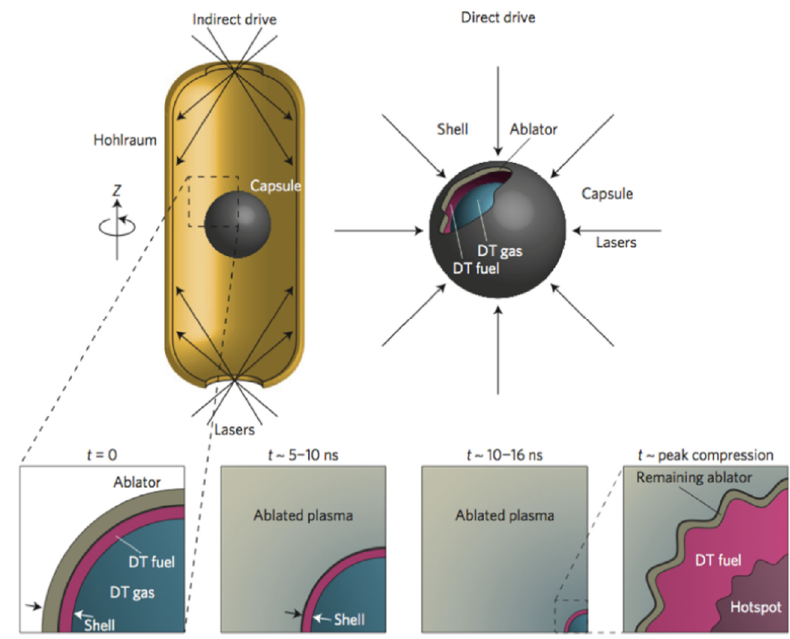
Figure 2. Inertial confinement fusion